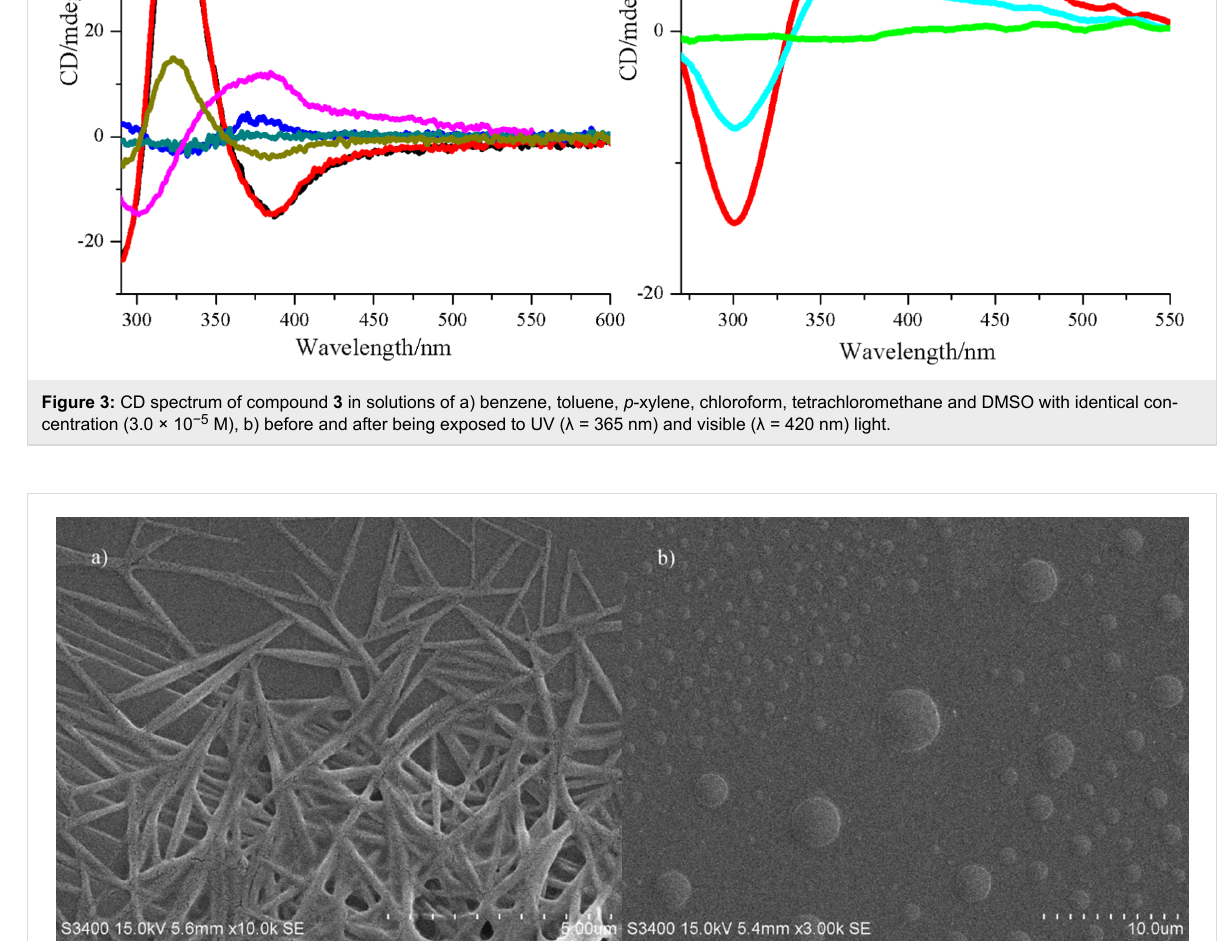
detected by SEM, whereby only small discs were found